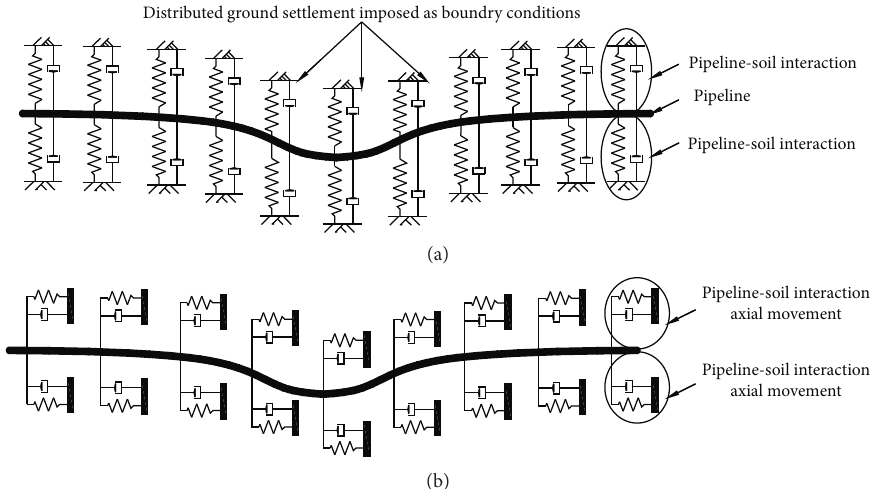
Figure 4: Schematic diagram of pipeline-soil interaction: (a) upward and downward relative displacements; (b) axial relative